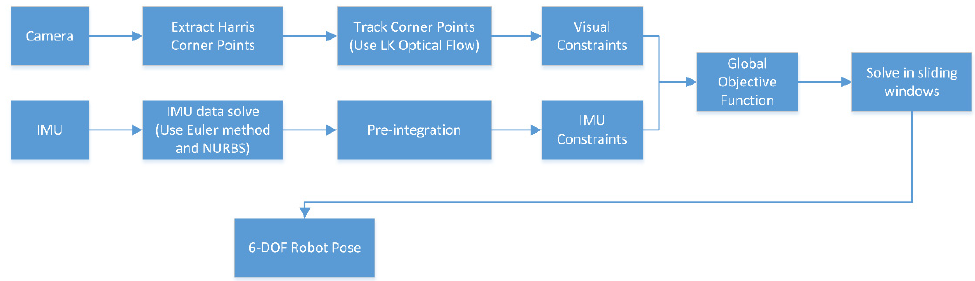
Figure 4. The entire process of tightly coupled visual and IMU fusion.